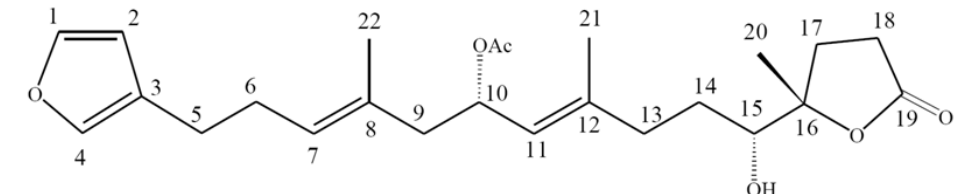
Figure 1. Chemical structure of 10-acetylirciformonin B isolated from marine sponge Ircinia